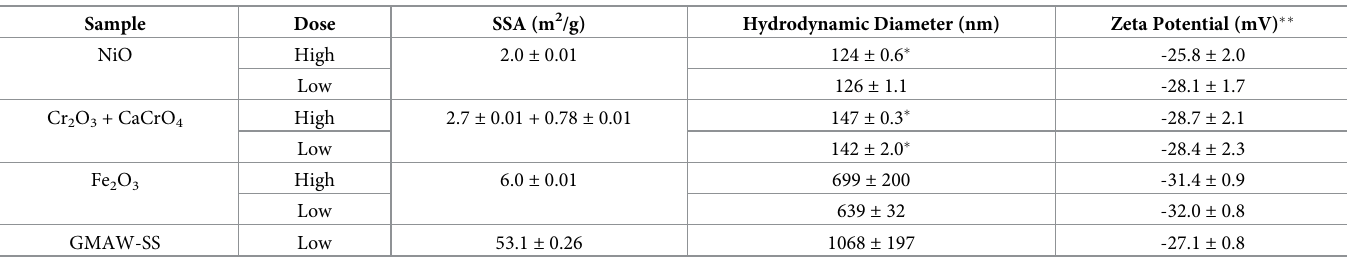
Table 2. Characteristics of metal oxides and GMAW-SS